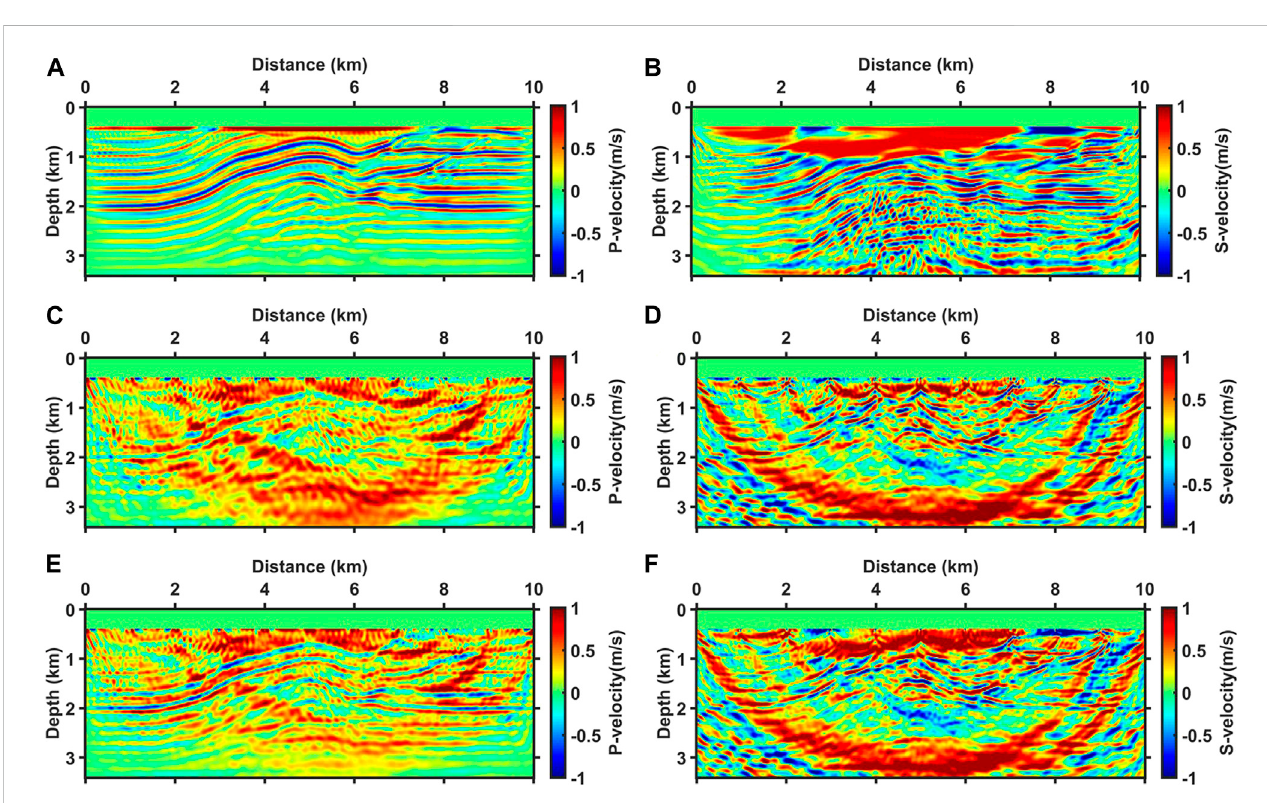
The P-wave velocity (A,C,E) and S-wave velocity (B,D,F) updating directions for the fi rst iteration of three inversion experiments. (A,B) are updating directions of towed streamer data alone, (C,D) are updating directions of OBS data alone, and (E,F) are updating directions of joint towed streamer and OBS